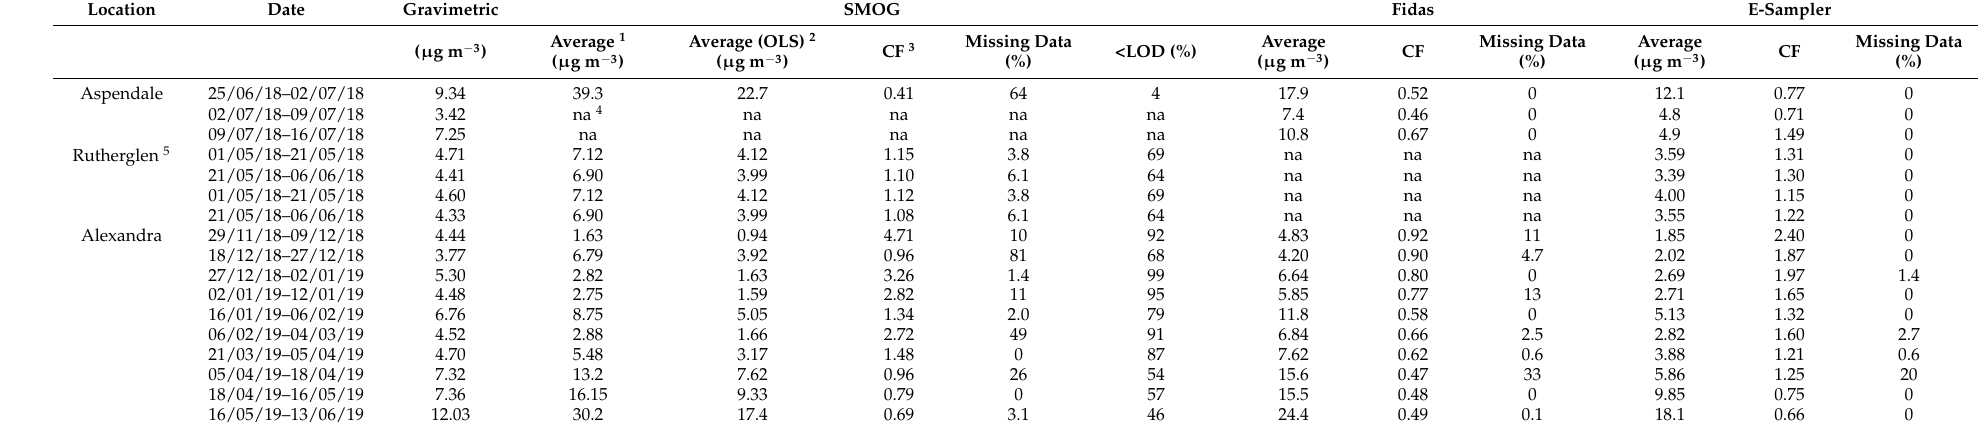
Table 3. Comparison between gravimetric PM 2.5 mass concentrations and PM 2.5 concentrations measured using optical instruments, including raw and calibrated SMOG data.